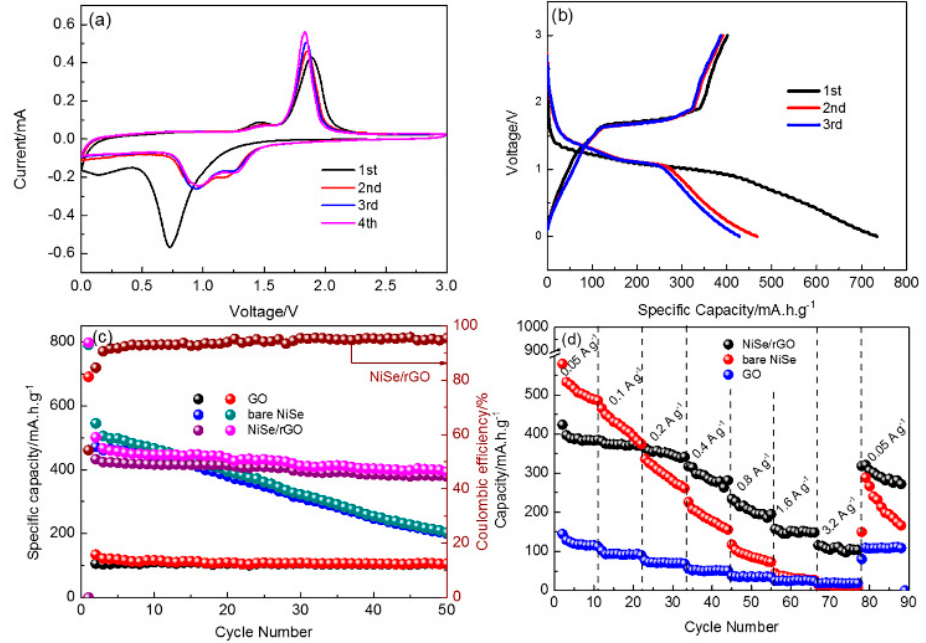
Figure 5. Sodium storage performances of as-prepared electrodes. ( a ) cyclic voltammograms of NiSe / rGO at a scan rate of 0.1 mV s − 1 ; ( b ) the initial three cycles of NiSe / rGO composite electrode at 0.05 A g − 1 ; ( c ) cycling performance; and ( d ) rate performance of NiSe / rGO composite, bare NiSe and rGO electrodes.